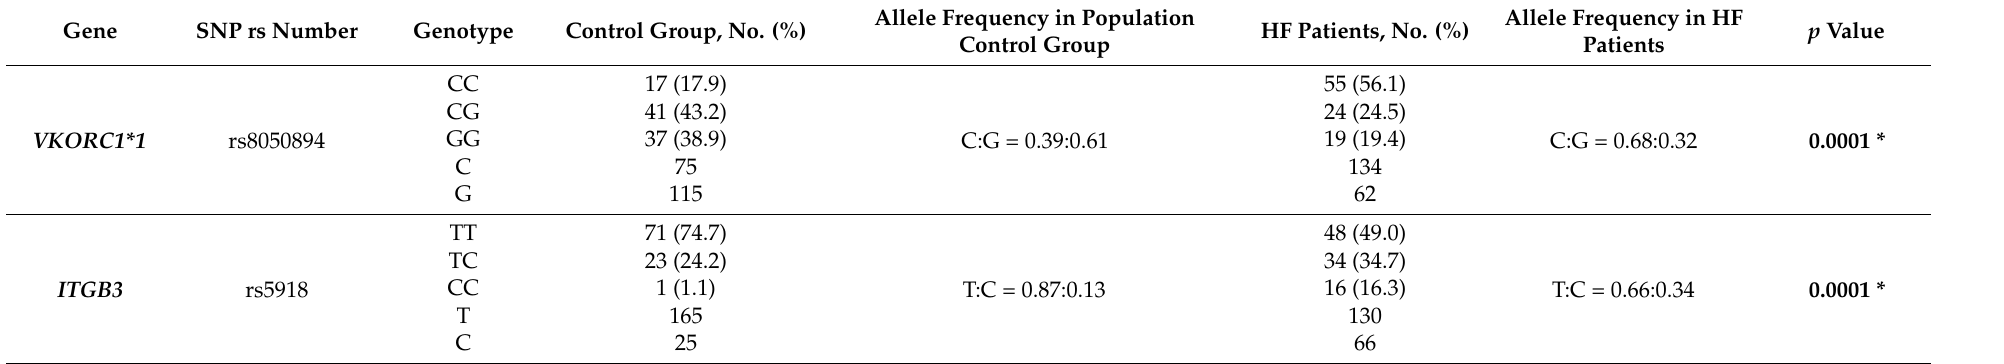
Table 4. The distributions of allelic and genotype frequencies of 21 SNPs between Control group and HF patients.